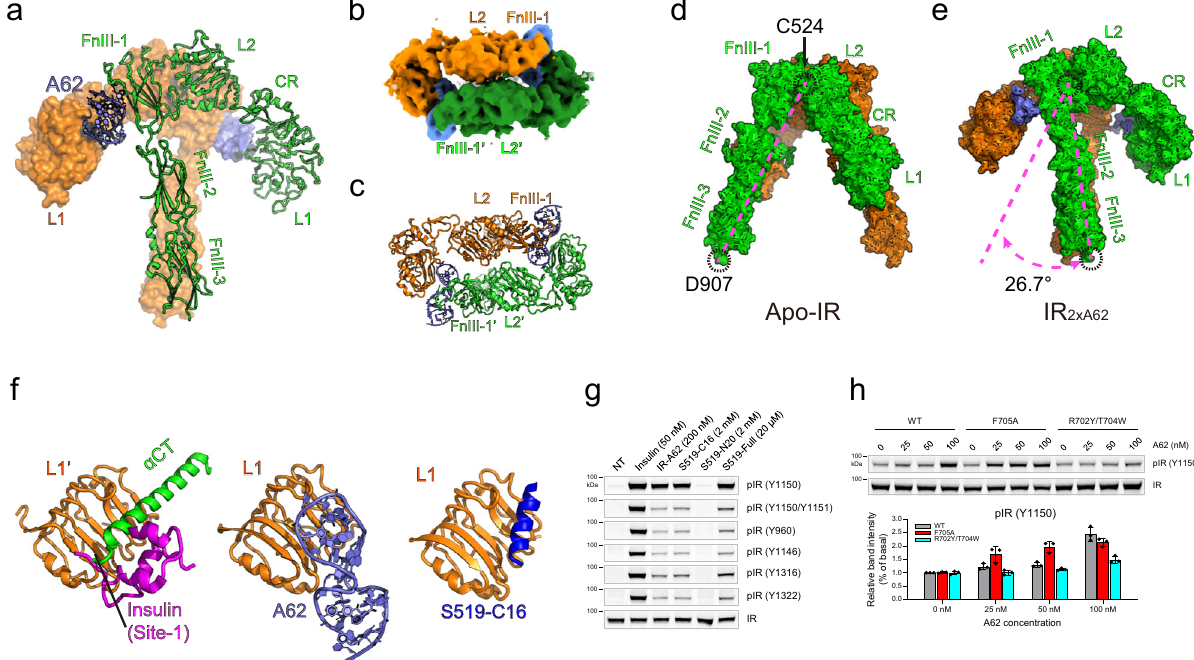
Fig.1|Cryo-EMstructuresofA62-boundIRintermediates.a StructureofIR 2xA62 , with one protomer (orange) shown in surface representation and another proto- mer (green) in ribbon representation. A62 aptamers are colored violet. b Surface representation of the IR 2xA62 complex in the top view. Each protomer is shown in orange or green. The A62 aptamers are colored violet. c Ribbon representation of Fig. 1b in the same orientation. d , e Comparison of the structures between apo-IR ( d ; PDB: 4ZXB) 33 and IR 2xA62 dimers ( e ). The angle of rigid body rotation was measured as the angle change of Asp907 centered on Cys524 of each protomer. f StructureofA62bindingcompetitivelytoL1withinsulinandthe α CTdomain.The close-up view shows the α CT+insulin+L1 complex (left) and the A62+L1 complex (middle) of the IR 2xA62 structure. The S519-C16 peptide (blue; PBD: 5J3H, right) 35